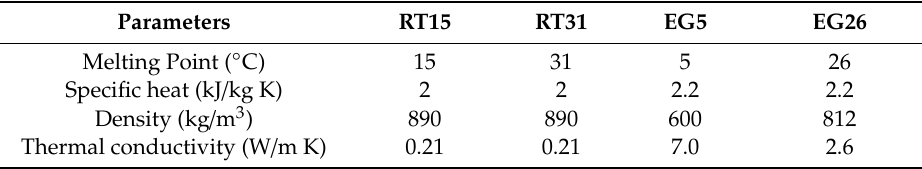
Table 3. Thermo physical properties of